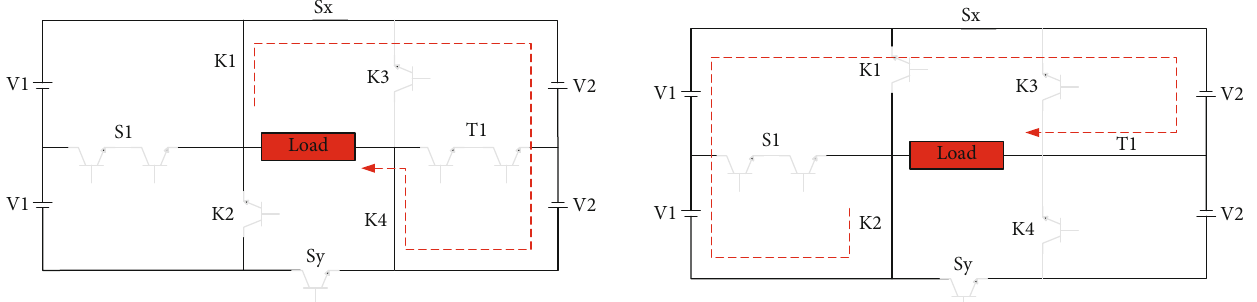
Figure 11: Current fl ow for the 9 th switching pattern.